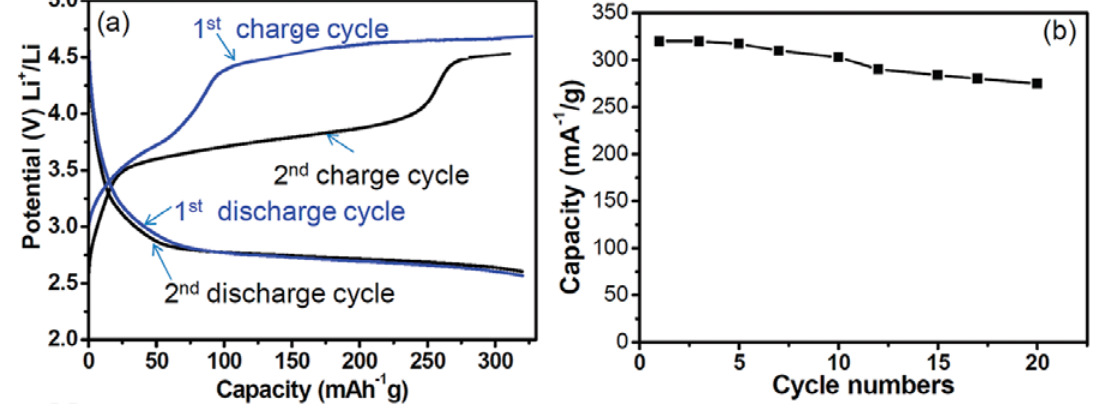
Figure 5. Charge and discharge profile of first and second cycles. ( a , c ) Li MnSiO at 45 °C, cycling at a current rate of C/50; ( b , d ) The cycling performance of Li 2 4 Li FeSiO and Li MnSiO , respectively . Adapted with permission from [35]. Copyright 2 4 2 4 2012 American Chemical